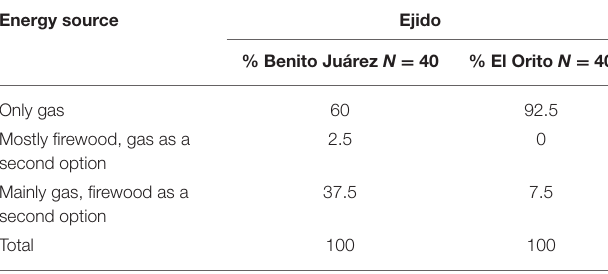
TABLE 2 | Domestic energy sources in El Orito and Benito Juárez. Energy